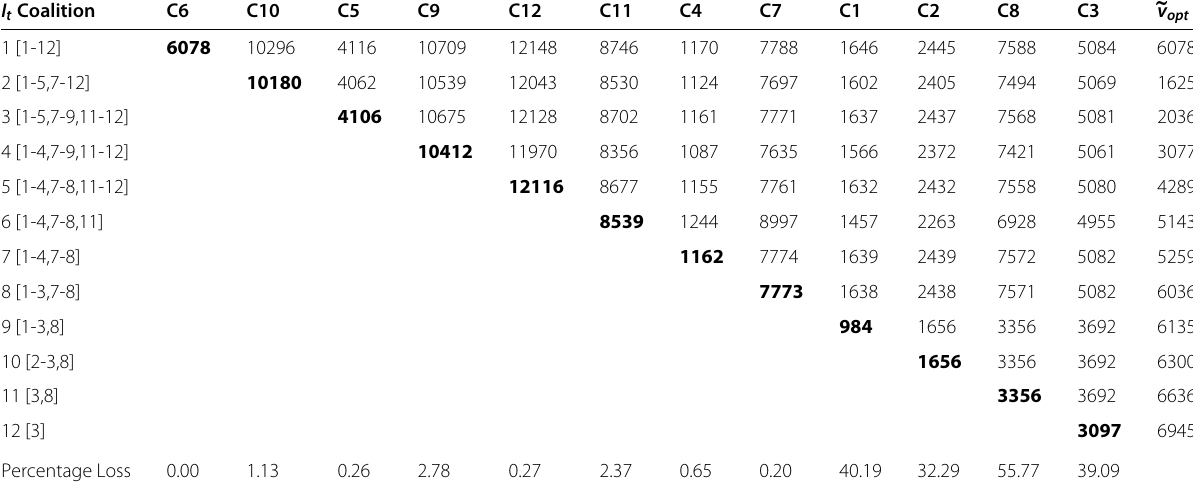
Table 3 In each iteration I t , for 1 ≤ t ≤ 12, the oligopolist buys out a cloud provider by offering him a price which is equal to his payoff in the remnant grand coalition. This payoff to a cloud provider is suitably marked in each row of the table. The second column represents the remaining coalition members. The last column labeled (cid:10) v opt represents the total price offer made by the oligopolist at the end of corresponding iteration. The last row gives the percentage loss of a cloud provider due to the adaptive strategy when compared with the payoff he gets from the non-adaptive